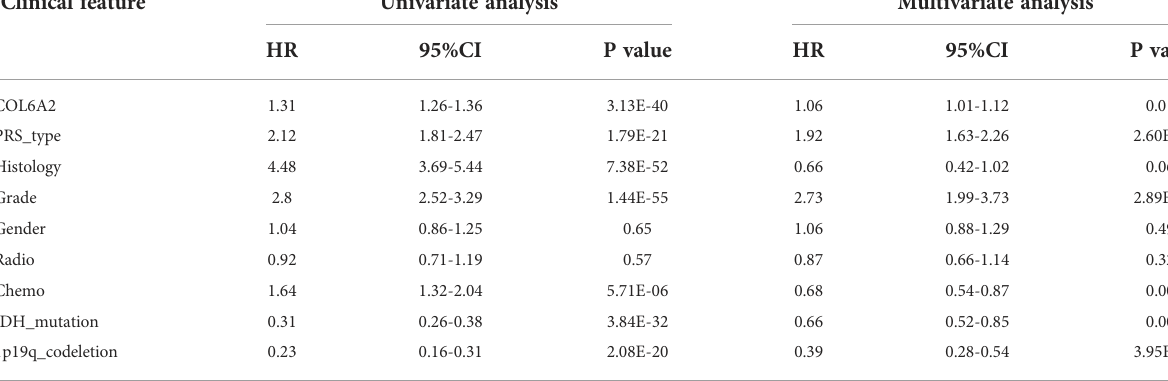
TABLE 2 Univariable and multivariable analyses for each clinical feature. Clinical